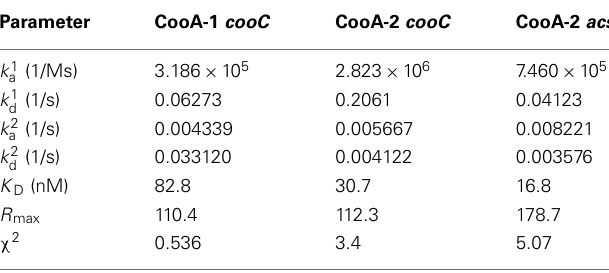
Table 2 | Biacore kinetic and affinity data for the binding of CooA-1 and CooA-2 to the cooC hyd and the acs promoter